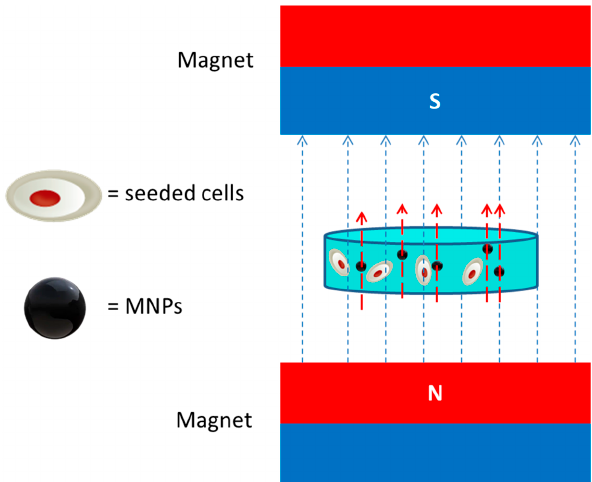
Figure 3. According to the reference [108], the amplification of the external magnetic field obtained by the presence of the dispersed nanoparticles is represented in the figure by means of the red arrows: the MNPs work as nanoantennas in the amplification of the applied magnetic field.